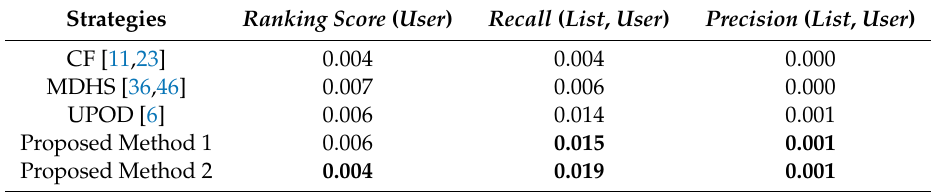
Table 4. Comparison of σ for the proposed methods with existing strategies— Last.FM .